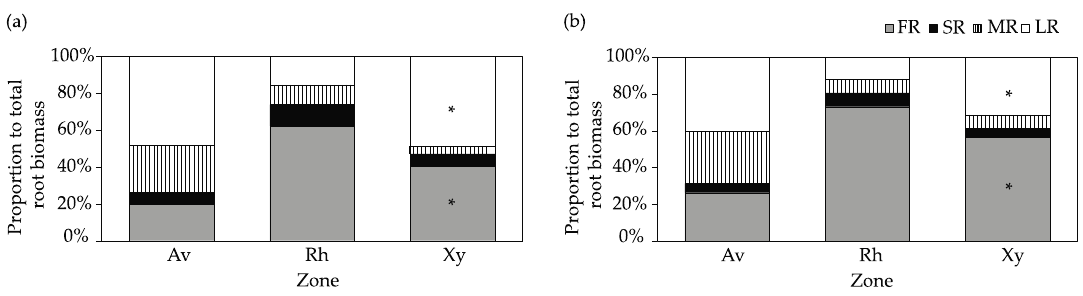
Figure 2. Proportion of root biomass in the Avicennia (Av), Rhizophora (Rh), and Xylocarpus (Xy) zones categorized into diameter classes, including fine roots (FR), small roots (SR), medium roots (MR), and large roots (LR), during the dry ( a ) and wet ( b ) seasons. The symbols indicate significant differences from a goodness-of-fit test with χ 2 ( p < 0.05) between seasons (*).